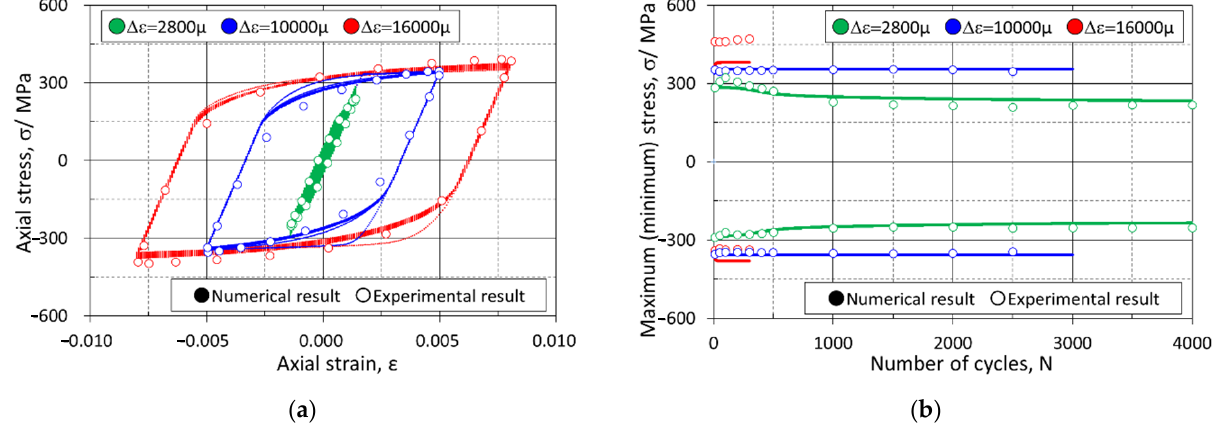
Figure 8. ( a ) Numerical stress and strain curves under constant amplitude loading; ( b ) numerical relationships between σ max- σ min and the number of cycles under constant amplitude loading.